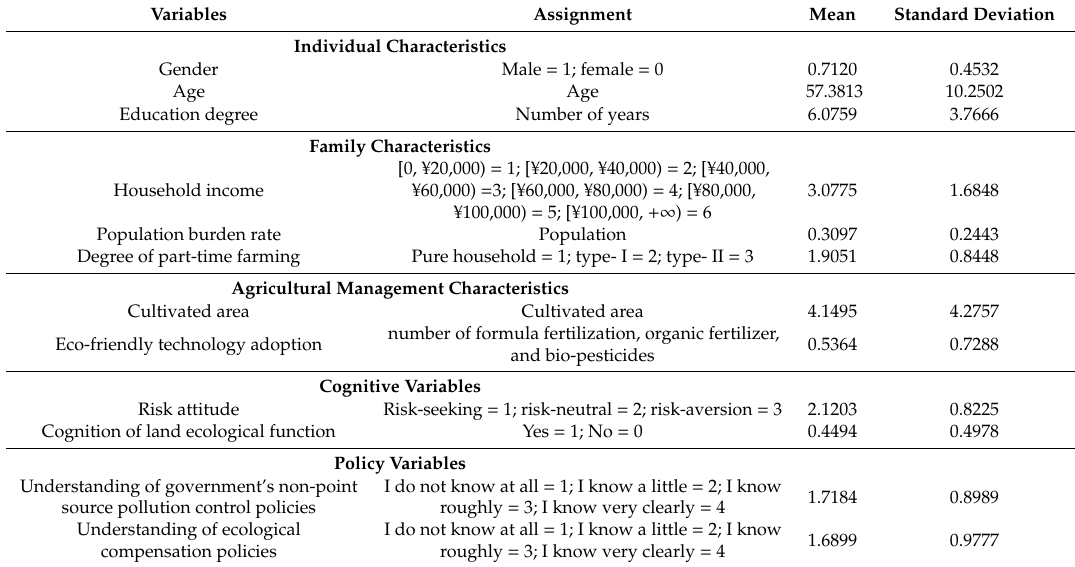
Table 2. Sample data descriptive